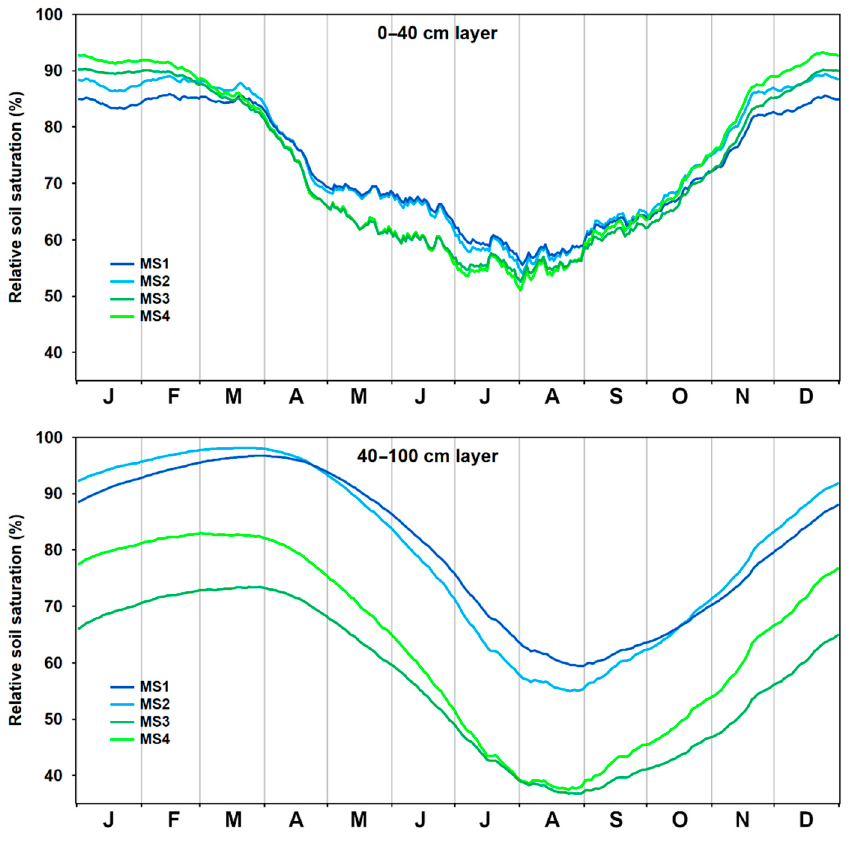
Figure 6. Annual variations in mean daily relative soil saturation (AWR) for 0–40 cm and 40–100 cm soil layers in the Czech Republic for the four SoilClim model setups MS1–MS4 in the 1961–2020 period.